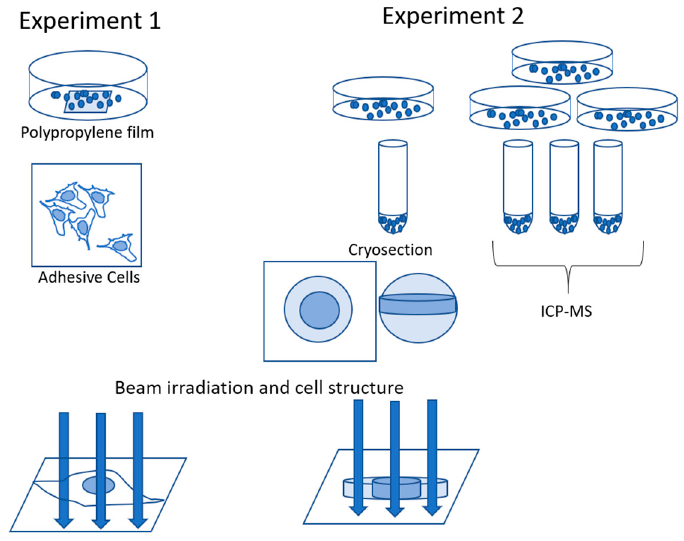
Figure 1. Experimental